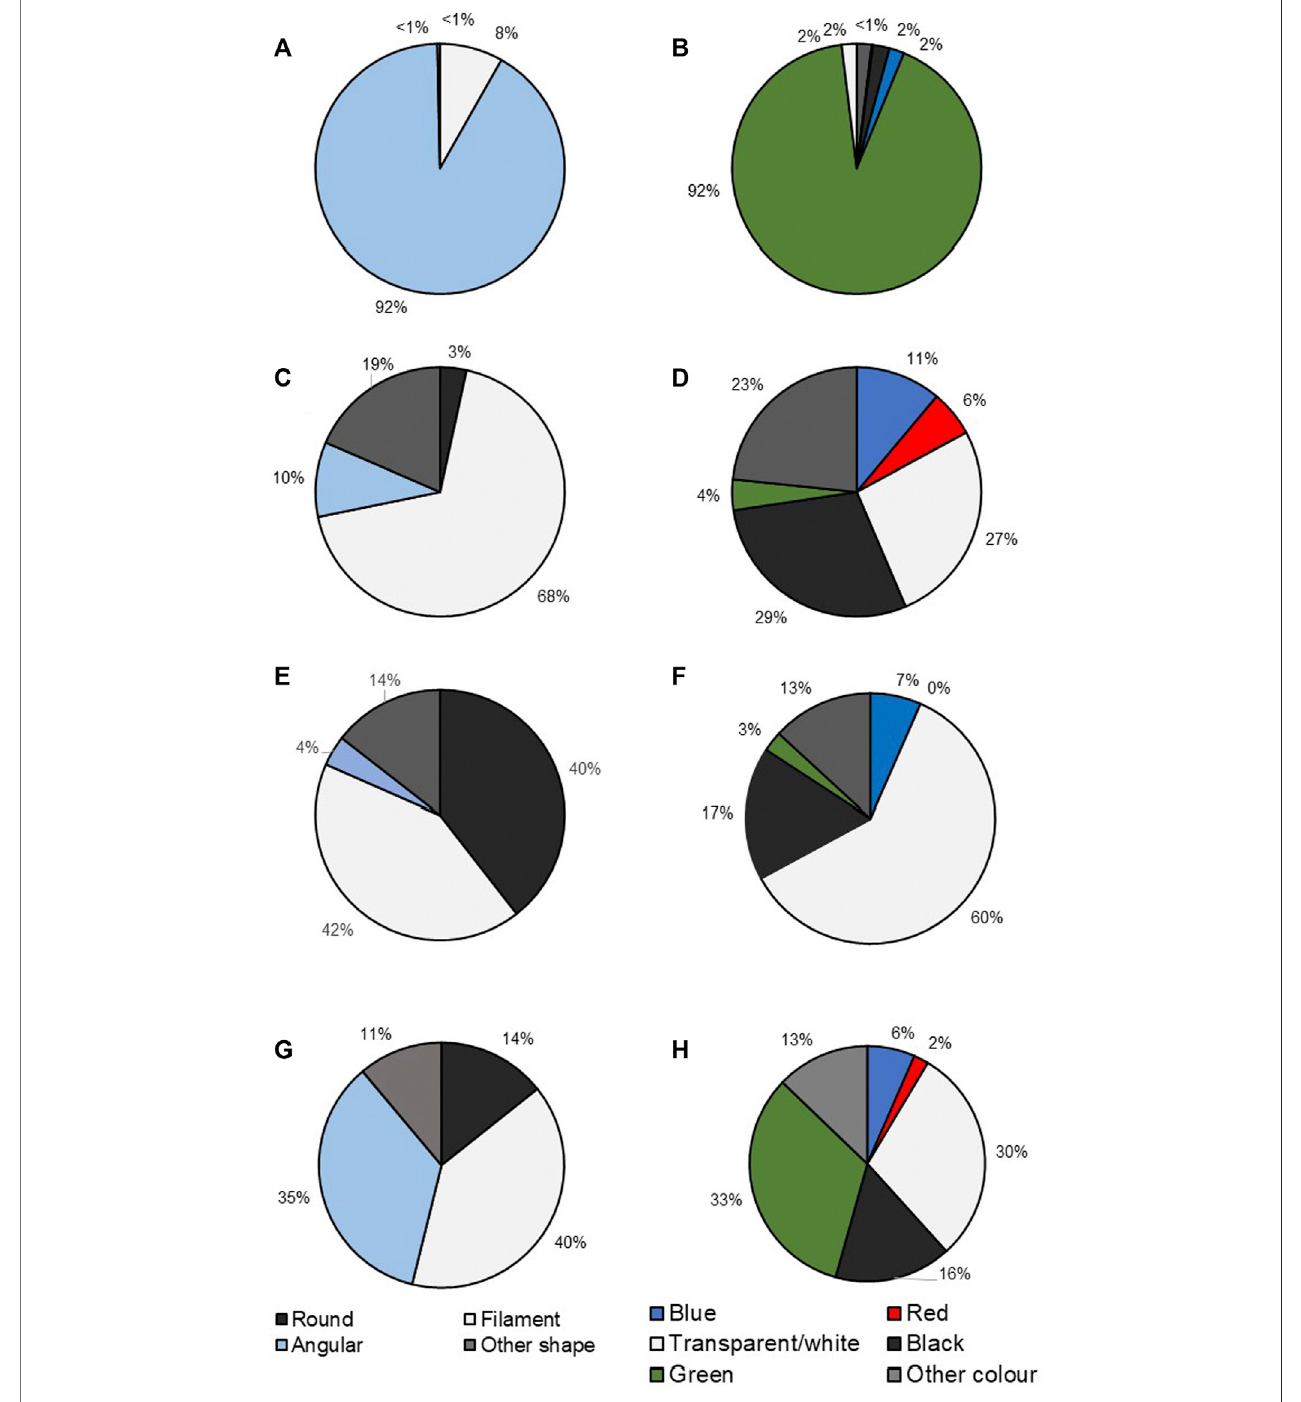
FIGURE 4 | Pie charts illustrating the different forms and colours of microplastics collected in (A) (forms in water), (B) (colours in water), (C) (forms in Clarias gariepinus.), (D) (colours in Clarias gariepinus), (E) (forms in sediment), (F) (colour in sediment), (G) (all forms in total), and (H) (all colours in total) in the upper Vaal River.